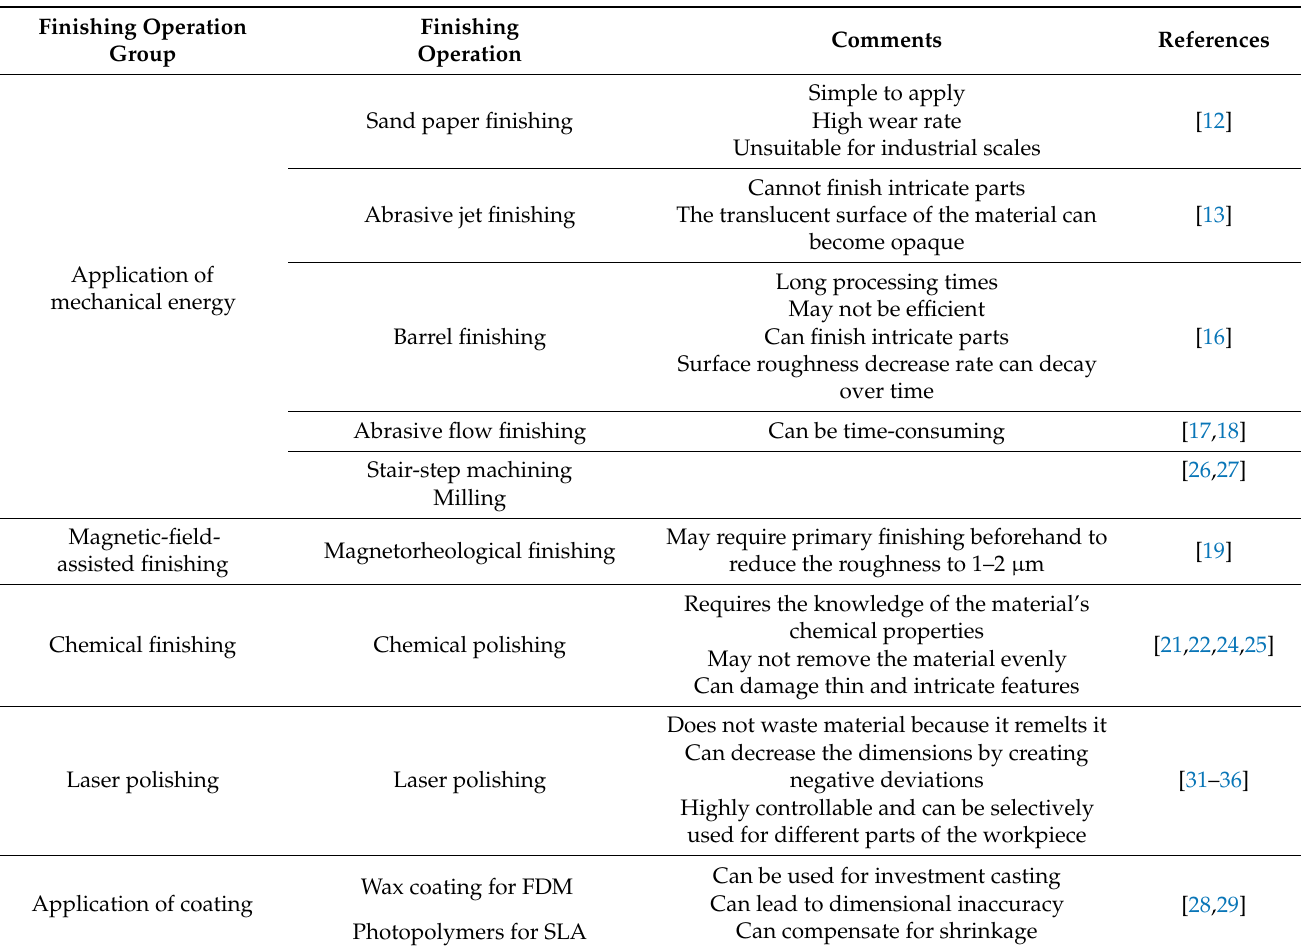
Table 1. Summary of the finishing processes for polymer using additive